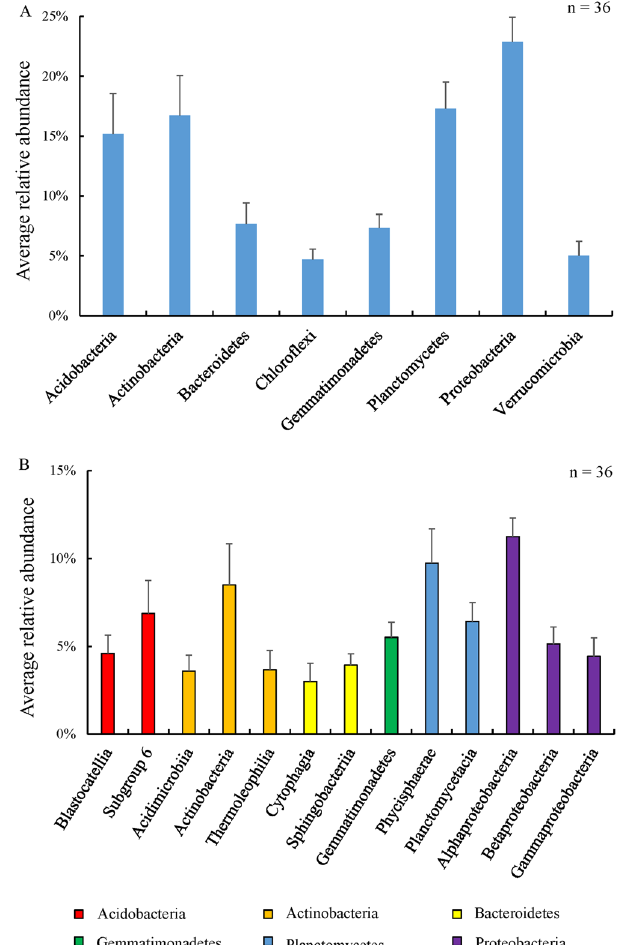
Figure 2. Average relative abundance of prokaryotic taxa in samples collected from rhizosphere soil at each developmental stage of Potentilla anserina . Average relative abundance was estimated for each prokaryotic taxon by dividing the total relative abundance across all samples by the number of samples (n = 36). The error bars show the standard deviation (calculation across 36 samples) for each average value. ( A ) Prokaryotic phyla with average relative abundance > 1% and ( B ) prokaryotic classes with average relative abundance >